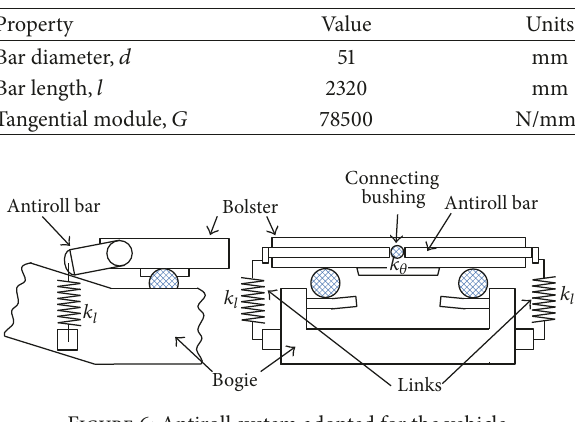
Figure 6: Antiroll system adopted for the vehicle.